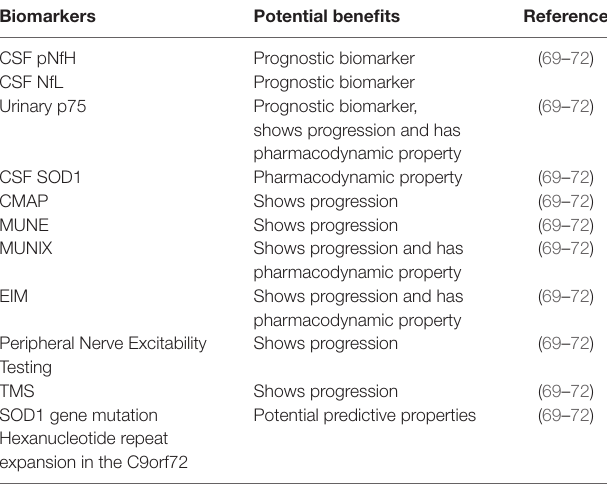
TABLe 4 | Biomarkers associated with amyotrophic lateral sclerosis and their potential benefits.